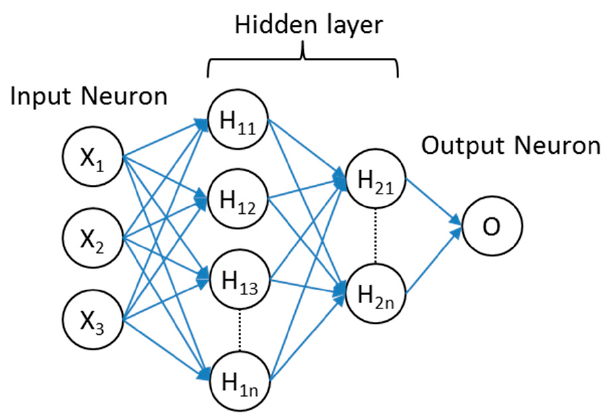
Figure 2. Architecture of a deep neural network (DNN) for strain prediction.